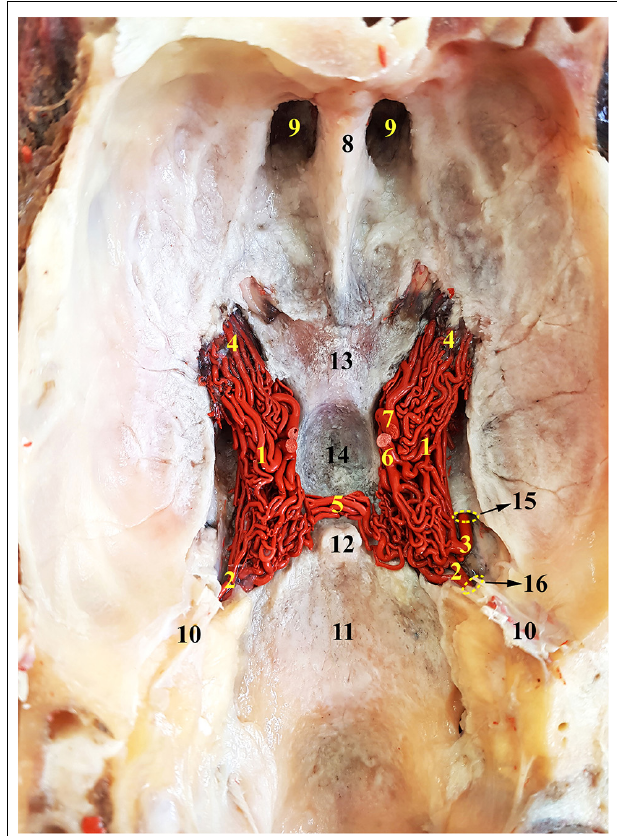
FIGURE 3 | Dorsal view of the RERM of the dromedary. 1, RERM; 2, internal carotid artery; 3, middle meningeal artery; 4, rostral root of the rete; 5, caudal connection of the rete; 6, caudal communicating artery; 7, rostral cerebral artery; 8, crista galli; 9, ethmoid fossa; 10, tentorium cerebelli; 11,